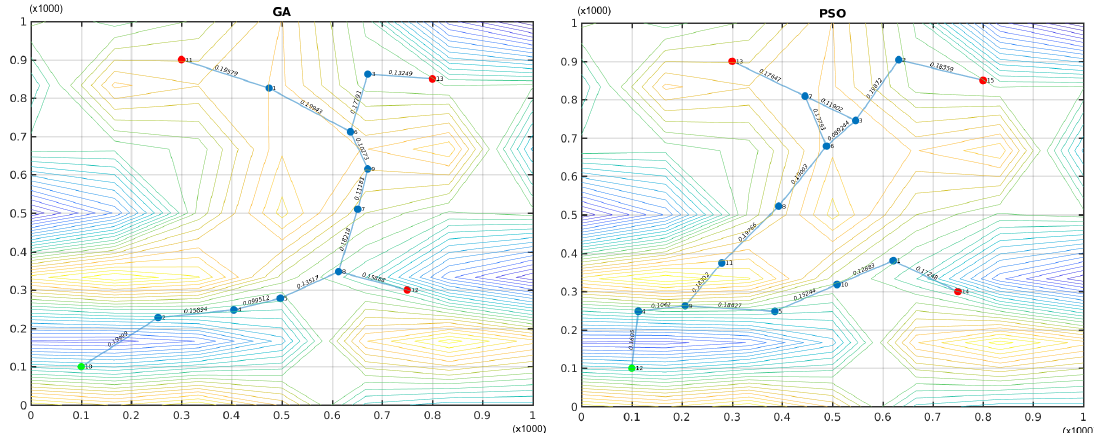
Figure 7. Sub-optimal network deployments generated by genetic algorithms (GAs) ( left ) and particle swarm optimization (PSO) ( right ). Green nodes represent the IC, red nodes are SAR teams, and blue nodes are